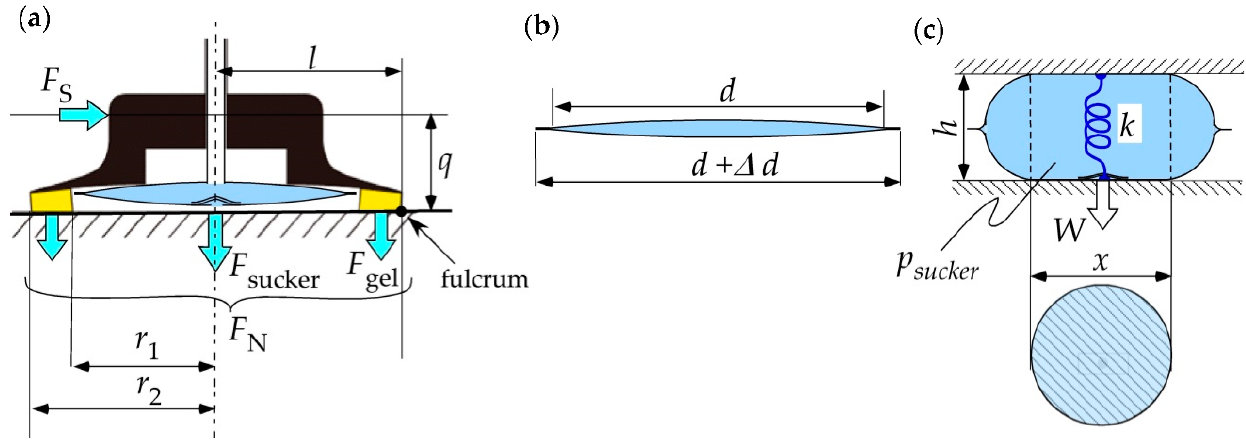
Figure 2. Design parameters: ( a ) supporting force in the perpendicular and shearing determined by the sticky force of the gel ring and the suction force; ( b ) cross-sectional view of the release balloon in the unpressurized state; ( c ) cross-sectional view of the release balloon in the pressurized state.